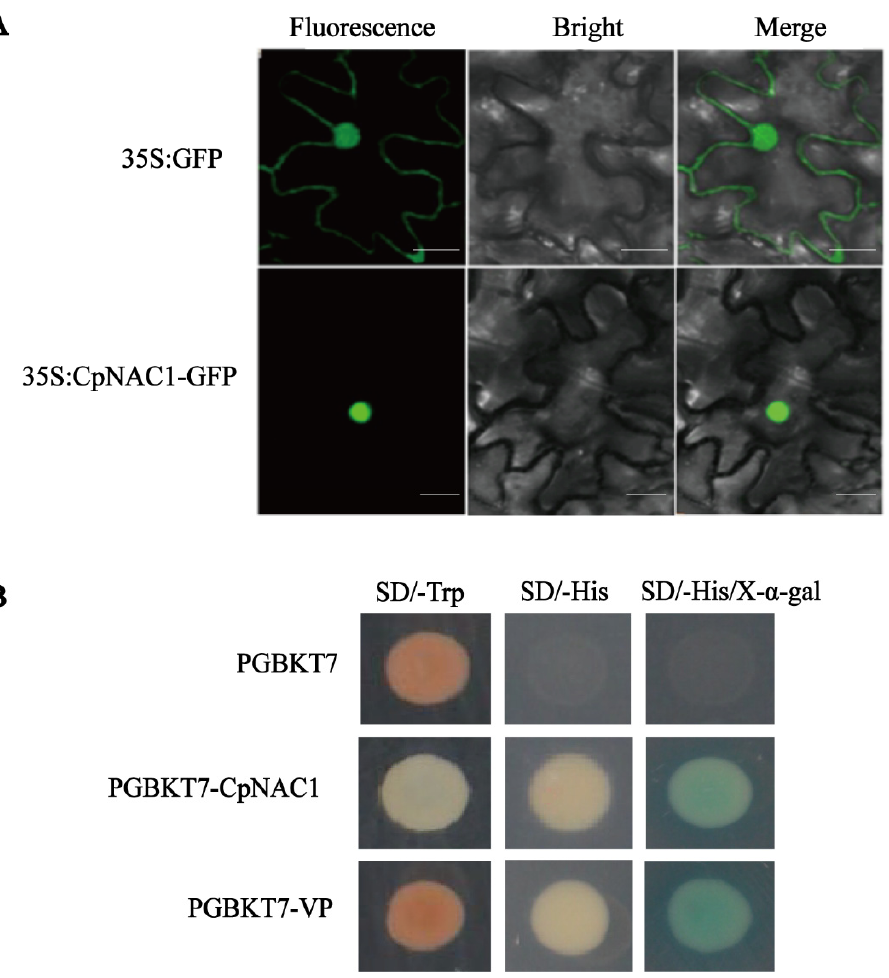
Figure 2. Subcellular localization and transactivation activity analysis of CpNAC1. ( A ) Subcellular localization of CpNAC1 protein. The fusion proteins 35S:GFP and 35S:CpNAC1 - GFP were expressed in tobacco leaf epidermis cells via Agrobacterium -mediated infection. 35S:GFP was used as the control. Bars denote 50 µ m. ( B ) Transactivation activity analysis of CpNAC1. The plasmids of pGBKT7- CpNAC1 , pGBKT7- VP (positive controls), and pGBKT7 (negative control) were transformed into the AH109 yeast strain. Growth and β -galactosidase activity were examined on SD/-Trp, SD/-His, and SD/-His/X- α -gal